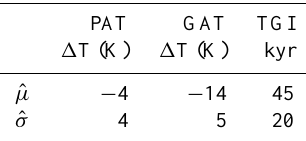
Table 6. Parameters used for the Monte Carlo simulations in this study. PAT is the long term average pre-glacial ground surface tem- perature, while GAT denotes the minimum temperature of the sim- plified glacial GSTH. This boxcar-like period of low temperatures begins at TGI. All values here are given as differences, taking the mean ground surface temperature before the LIA as a reference (see Fig. 7). All parameters were assumed to be independently and normally distributed. PAT GAT TGI 1 T (K) 1 T (K) kyr ˆ µ − 4 − 14 45 ˆ σ 4 5